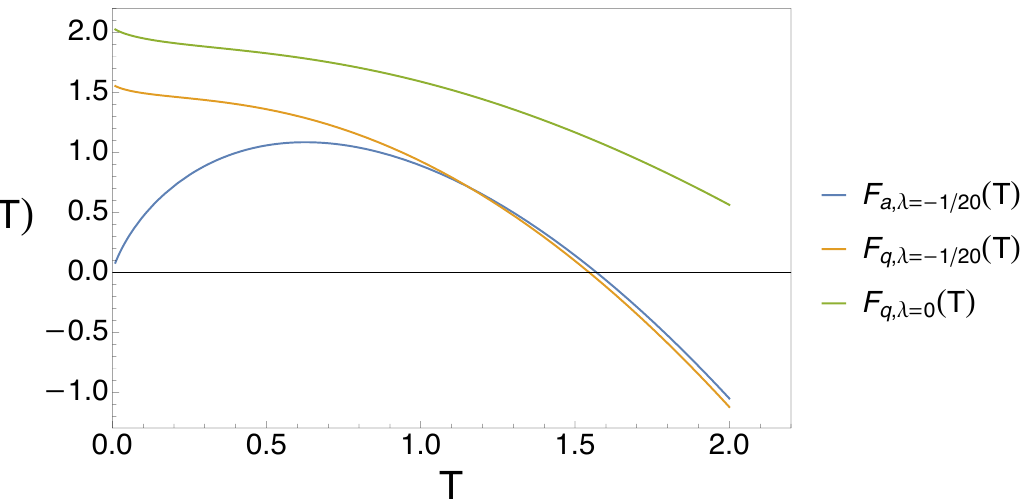
Figure 3. We plot the annealed and quenched free energies for the deformed Airy model as a function of temperature T . The blue and orange curves are quenched and annealed free energies respectively for the deformed theory at λ = − 1 / 20 and the green curve is the quenched free energy for undeformed Airy model. The good sign of the TT deformation lowers the quenched free energy.